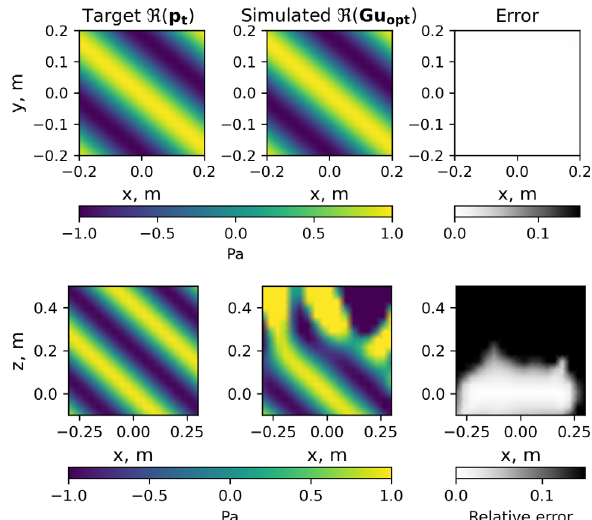
Figure 4. Real parts of the target and simulated sound pressure fi elds in the xy plane ( z = 0) and xz plane ( y = 0) at 1500 Hz for a plane wave of incidence / = 55 (cid:3) and azimuthal angle h = 50 (cid:3) . The regularization parameter k is equal to 10 (cid:3) 5 . The error between target and simulated sound pressure fi elds is shown in the right column.